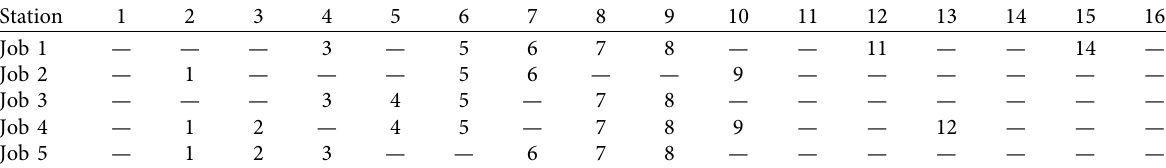
Table 10: Prerequisites for each activity.